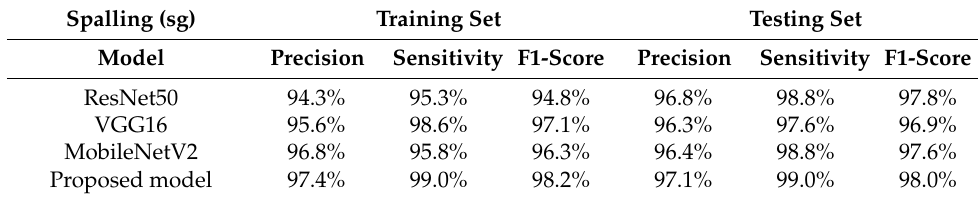
Table 8. Overall precision, sensitivity, and F1-Score of the spalling concrete.